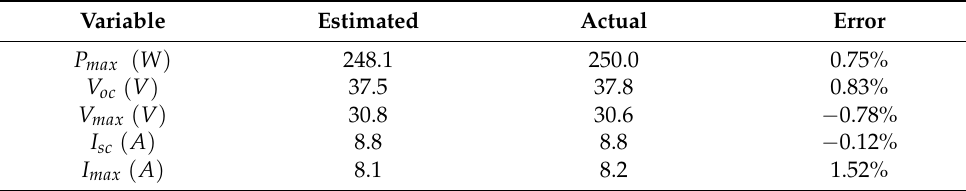
Table 6. Error rate between actual and estimated electrical characteristics. Table 7. Architectures used to generate the NARX models.